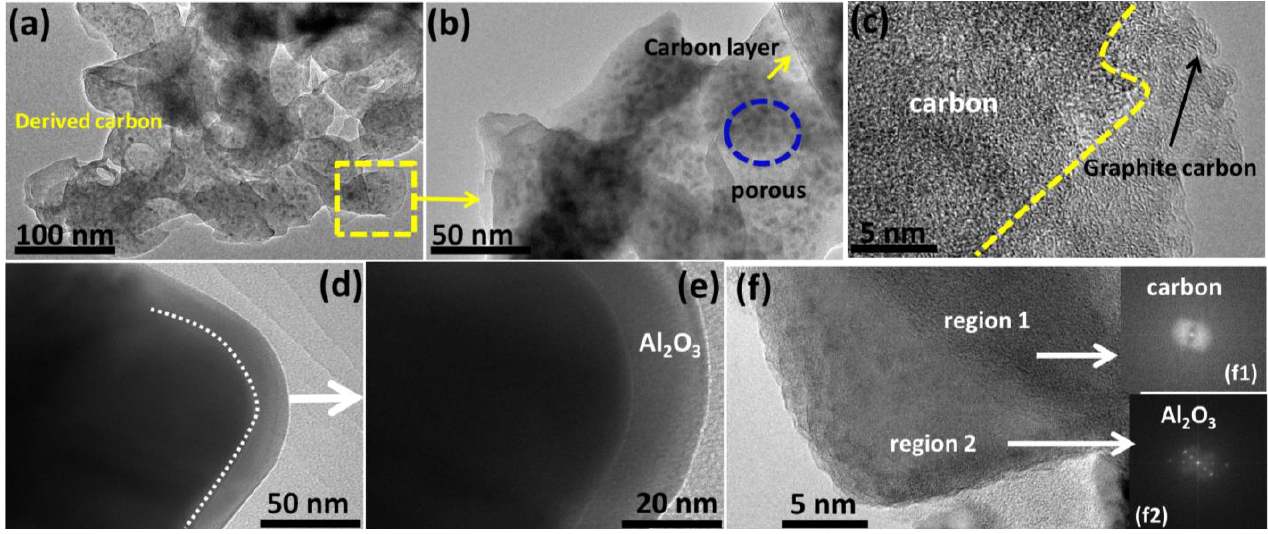
Figure 3. TEM images. ( a , b ) Derived carbon high porosity content area selection and ( c ) high-resolution TEM images of activated carbon different surface behavior. ( d ) TEM image of the C@Al 2 O 3 composition distribution, ( e ) TEM image of the carbon coating and Al 2 O 3 coating profile, and ( f ) two profiles, ( f1 ) typical carbon and ( f2 ) Al 2 O 3 of C@Al 2 O 3 nanocomposite.